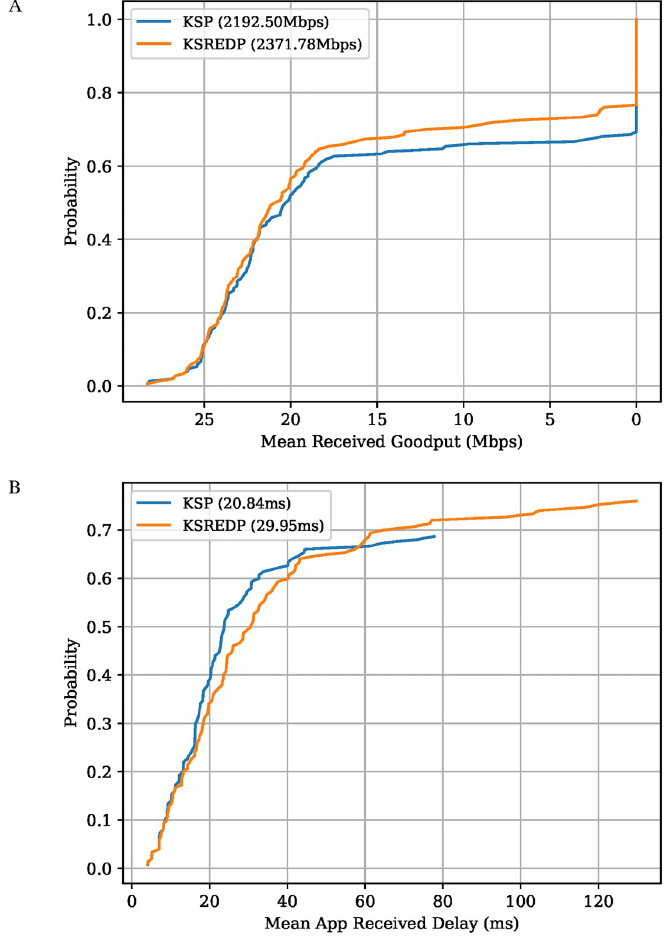
Fig 12. Network performance comparison between the path selection algorithms. A: Probability that a flow achieves at least a given average Received Goodput in Mbps, using network simulations. The total received Goodput achieved by each algorithm is shown in parentheses. The probabilities do not add up to one as unassigned flows are set with a delay value equal to infinity. B: Probability that a flow experiences at most a given average end-to-end delay at the application layer, using network simulations. The mean application delay achieved by each algorithm is shown in